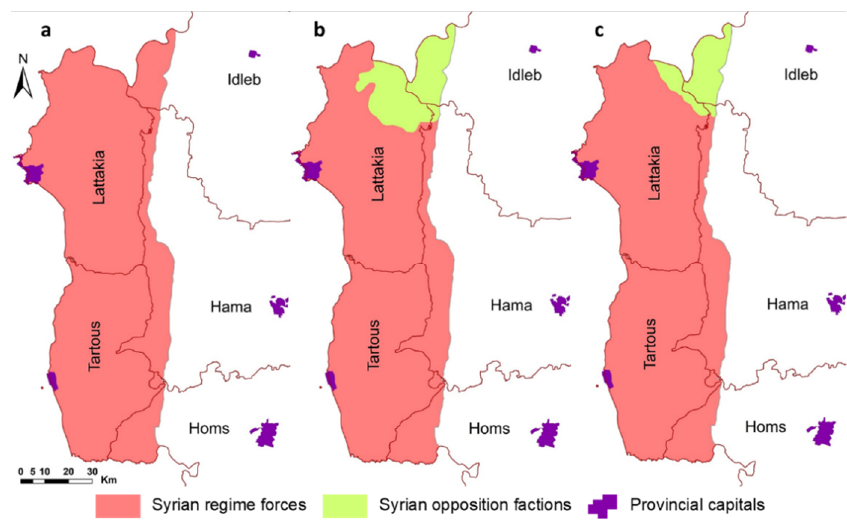
Figure 3. Distribution of zones of influence in the Syrian coast region between the warring parties at the end of 2010 ( a ), 2015 ( b ), and 2020 ( c ) adapted from [56]. Forests in the Syrian coast region are Mediterranean forests, and their spread is often linked to climate and landforms [57,58]. These forests contain trees of various ages and sizes, the most important of which are broad-leaf trees such as oaks ( Quercus ) of all kinds, conifers such as Aleppo pine ( Pinus halepensis ), and turpentine trees ( Pistacia palaestina ), which cover 57%, 29% and 9% of the forest area, respectively, in addition to the juniper ( Juniperus excelsa ), cilician fir ( Abies cilicica ), and cedar ( Cedrus libani ) trees that form high- altitude forests in the region [57,58]. Figure 4 shows the approximate distribution of main natural forests in the study area for the year 2010, which include evergreen forests (coniferous Forests) and moist deciduous forests (broad-leaved Forests). The natural non-forest vegetation consists of scrubs that include small areas of sparse vegetation and low shrubs [57–60]. Table 1 also shows the area of these forests in the study area.